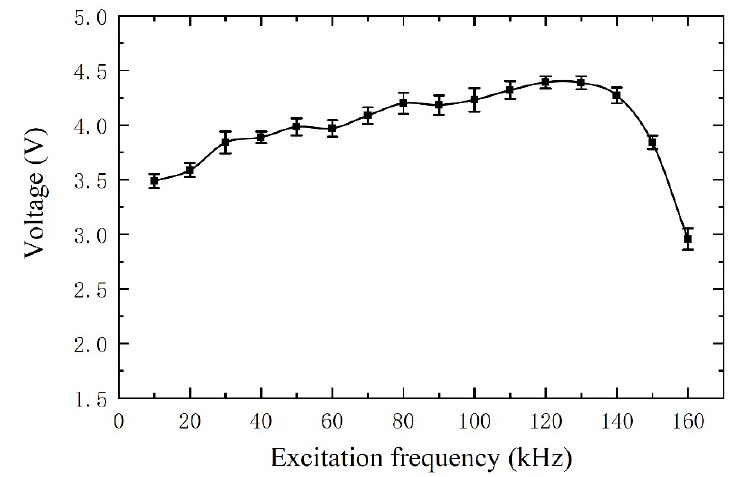
Figure 9. The sensor’s frequency characteristic.